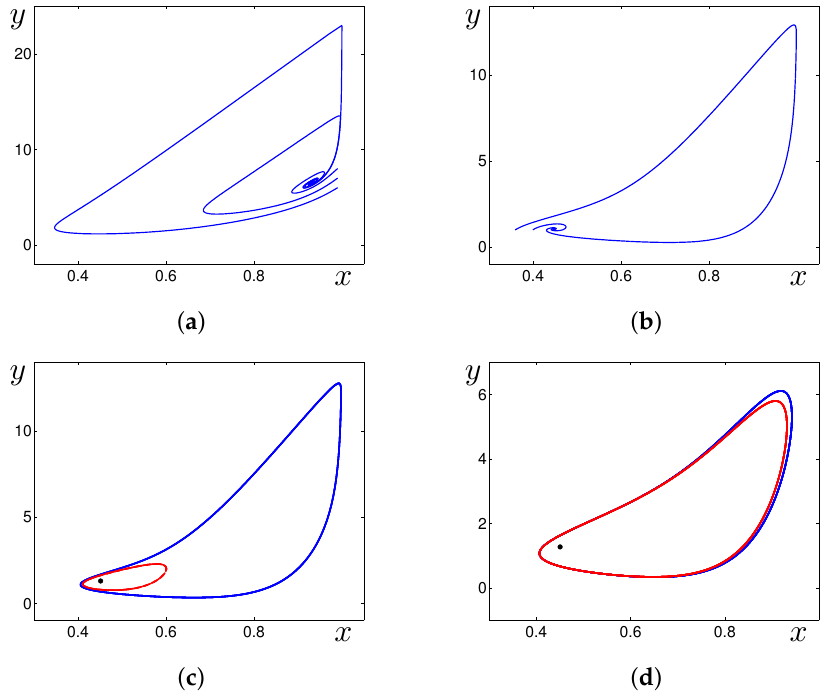
Figure 2. Phase portraits of the system (1) for ( a ) D = 0.1, ( b ) D = 0.3, ( c ) D = 0.245, ( d ) D =